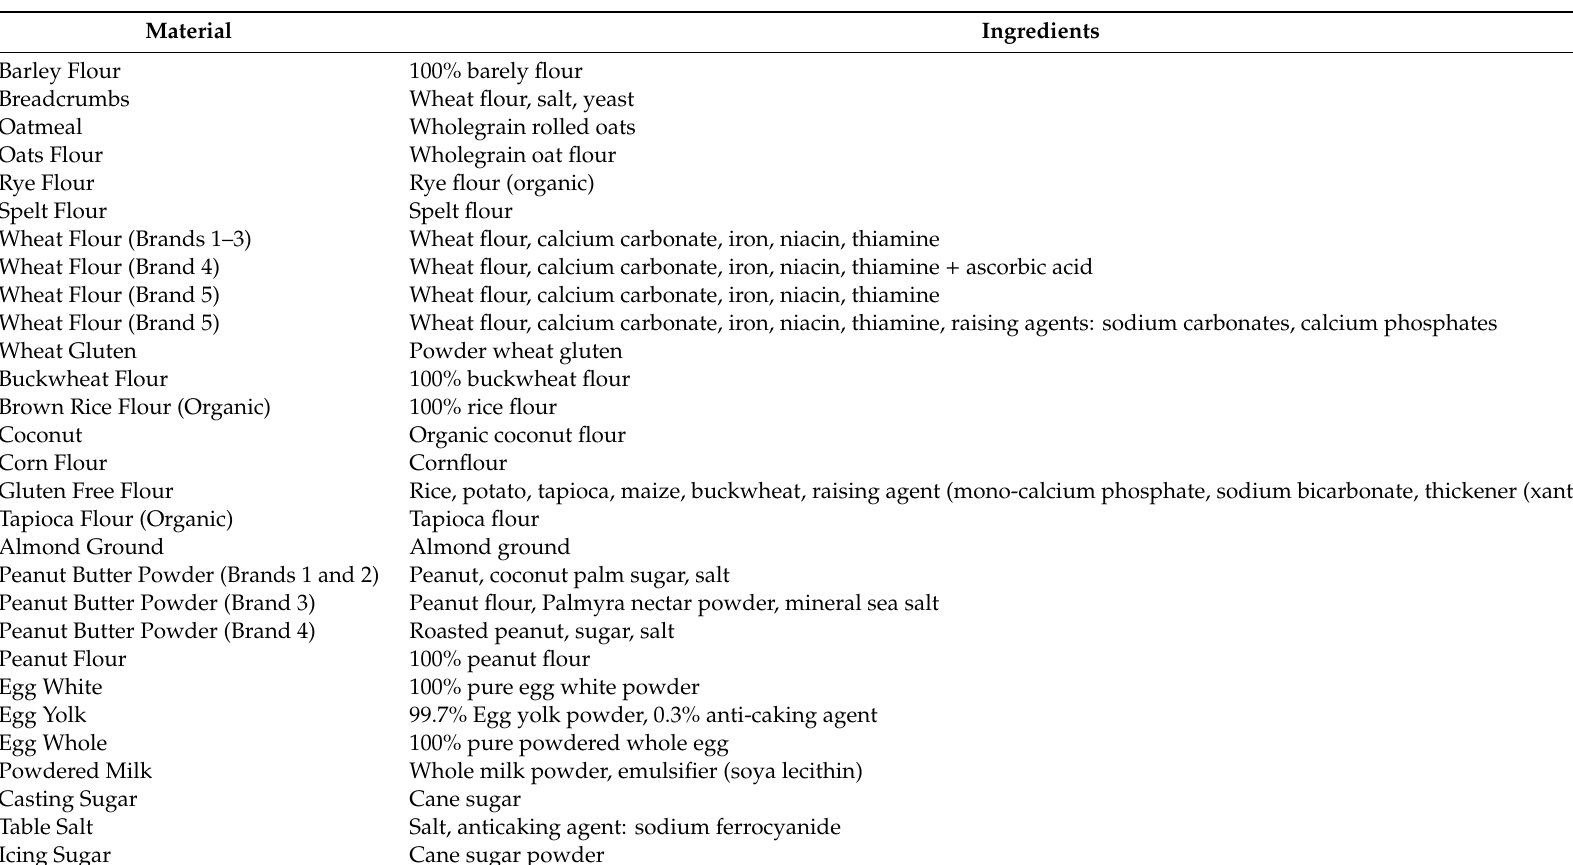
Table 2. Ingredients of the materials for the flour group (FG) scanned by the NIR sensor.